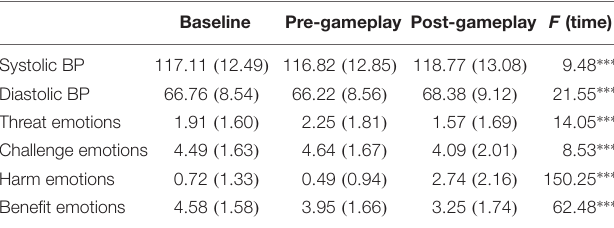
TABLE 5 | Mean (SD) changes in blood pressure measures and emotion ratings over